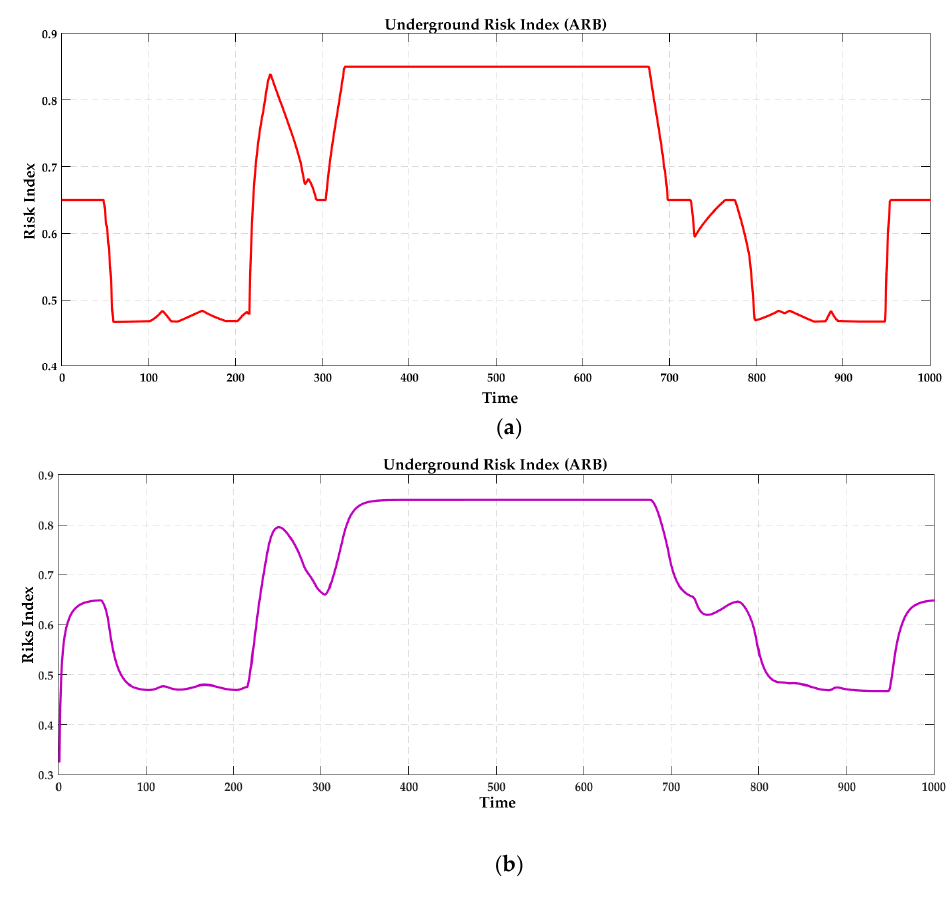
Figure 18. ( a ) Output values of SHFL model using A RB rules; ( b ) predicted values using Kalman filter for underground risk index.